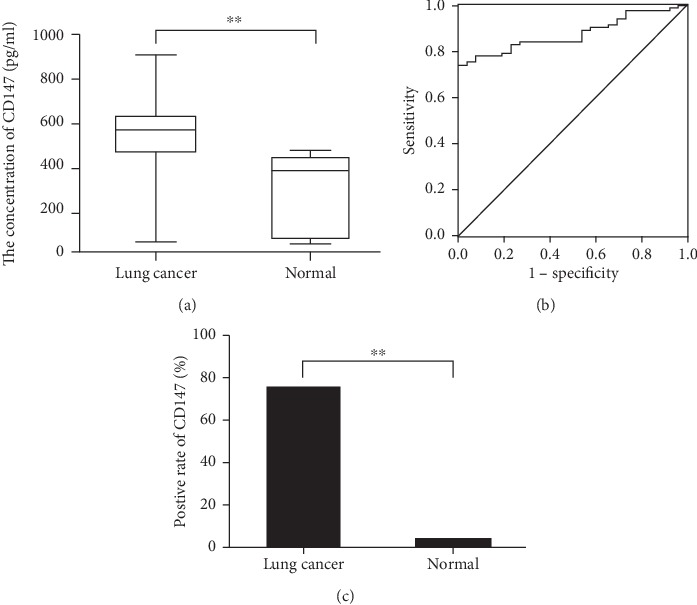
(a) Differences in the serum concentrations of CD147 between patients with lung cancer (LC) and healthy volunteers (HVs). (b) The diagnostic value of serum concentrations of CD147 for identifying LC in a receiver operating characteristic curve. (c) Differences in the positive rate of serum concentrations of CD147 between patients with LC and HVs. ∗∗P < 0.01.